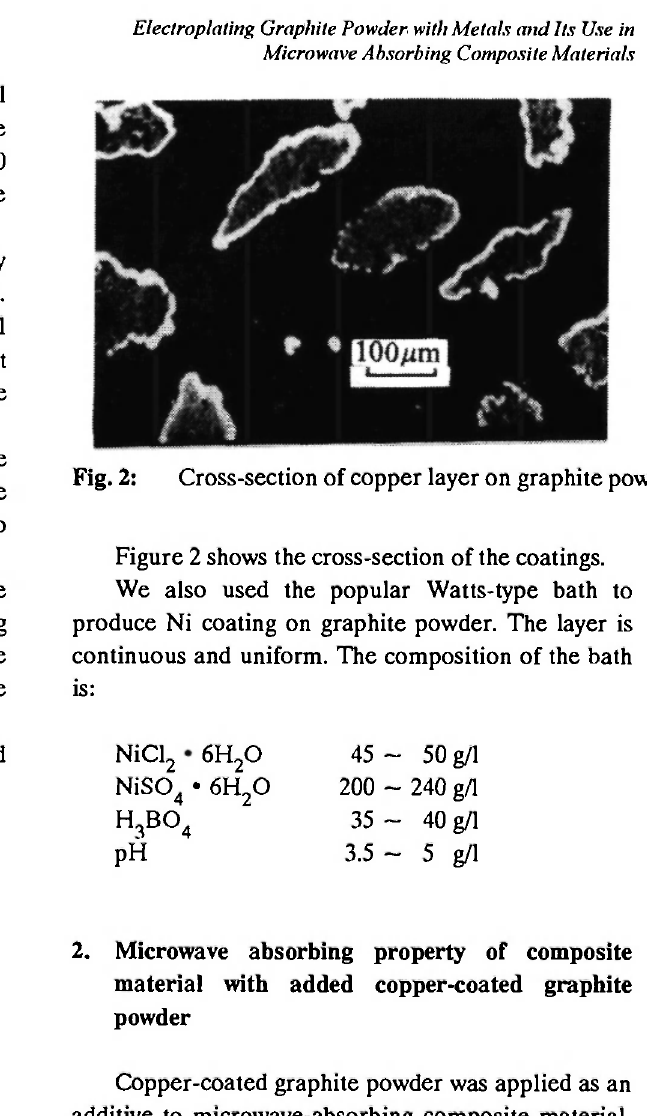
Fig. 1: Schematic installation for electroplating graphite powder with metals